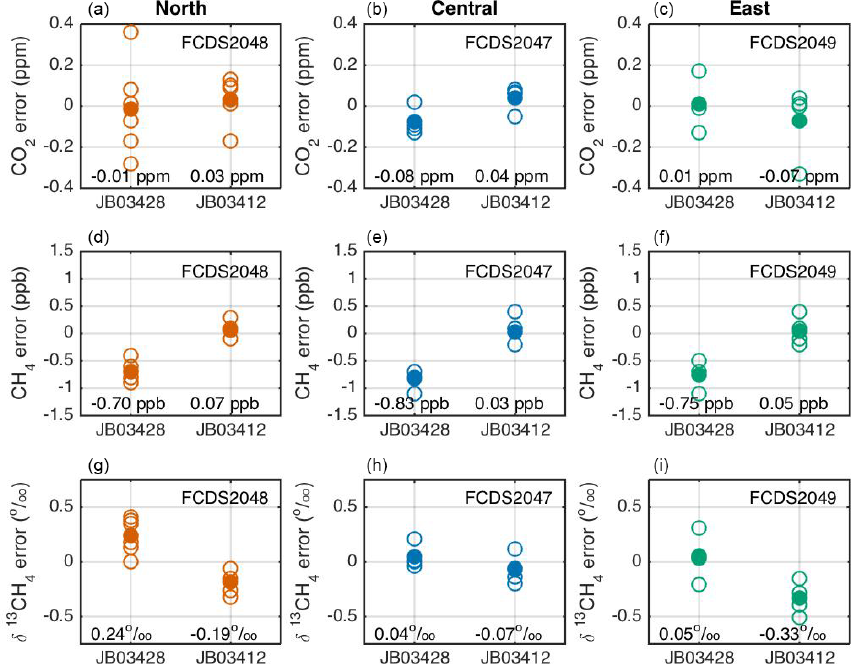
Figure 10. Results from round-robin style testing using two NOAA/INSTAAR tanks (JB03428: − 46.82‰ δ 13 CH 4 , 1895.3ppb CH 4 , and 381.63ppm CO 2 ; JB03412: − 45.29‰ δ 13 CH 4 , 2385.2ppb CH 4 , and 432.71ppm CO 2 ) for CO 2 (a, b, c) , CH 4 (d, e, f) , and δ 13 CH 4 (g, h, i) for the analyzer deployed at the north tower (serial number FCDS2048; a, d, g ), at the central tower (serial number FCDS2047; b, e, h ), and at the east tower (serial number FCDS2049; c, f, i ). These tests were completed in the laboratory, post-deployment (March 2017). The analyzer deployed at the south tower (serial number FCDS2046) was not included in these tests. Open circles are individual tests, and filled circles are the means of the individual tests for each analyzer/constituent. The mean error for each analyzer/tank/constituent is indicated in the